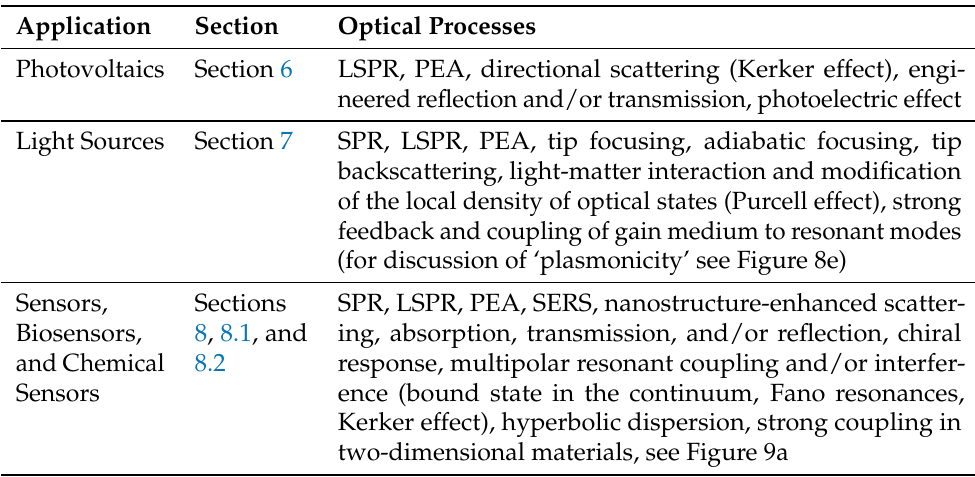
Table 1. Examples of plasmonic applications and most common optical processes involved (surface plasmon resonance (SPR), localized surface plasmon resonance (LSPR), plasmon-enhanced absorption (PEA), photoelectric effect, and